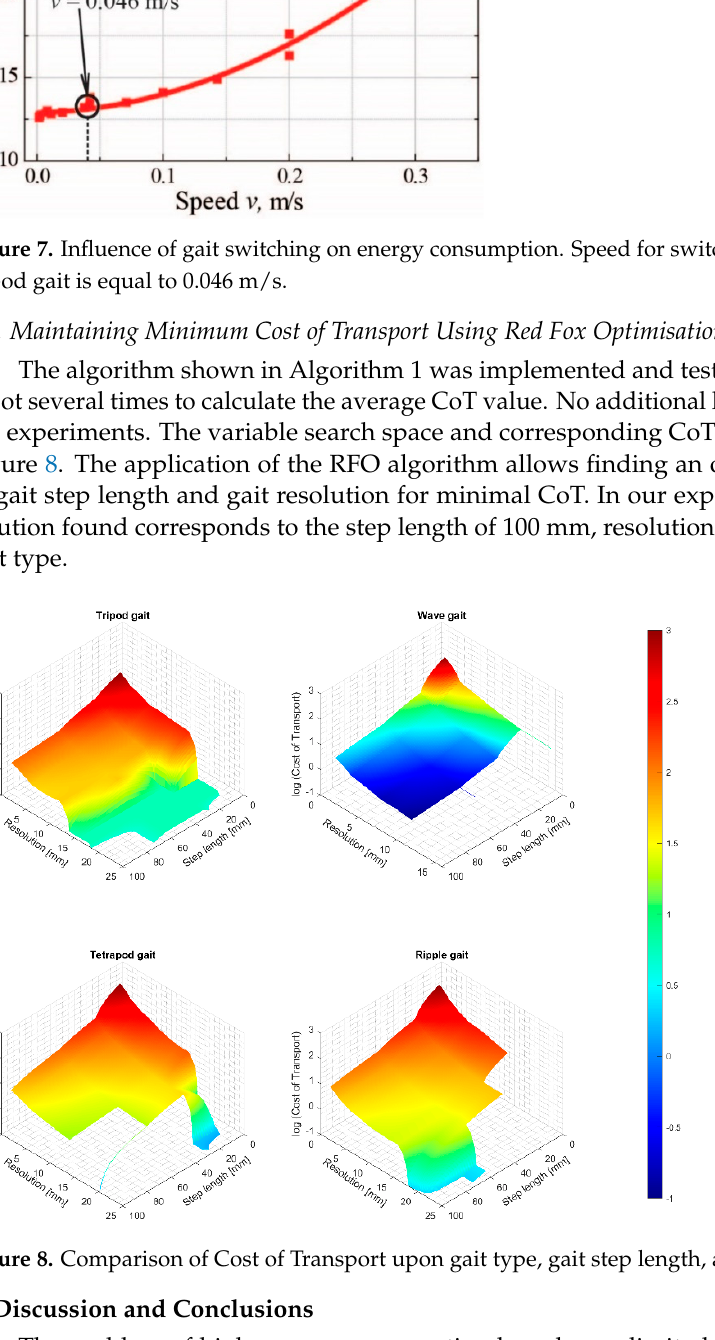
Figure 7. Influence of gait switching on energy consumption. Speed for switching from wave gait to tripod gait is equal to 0.046 m/s.